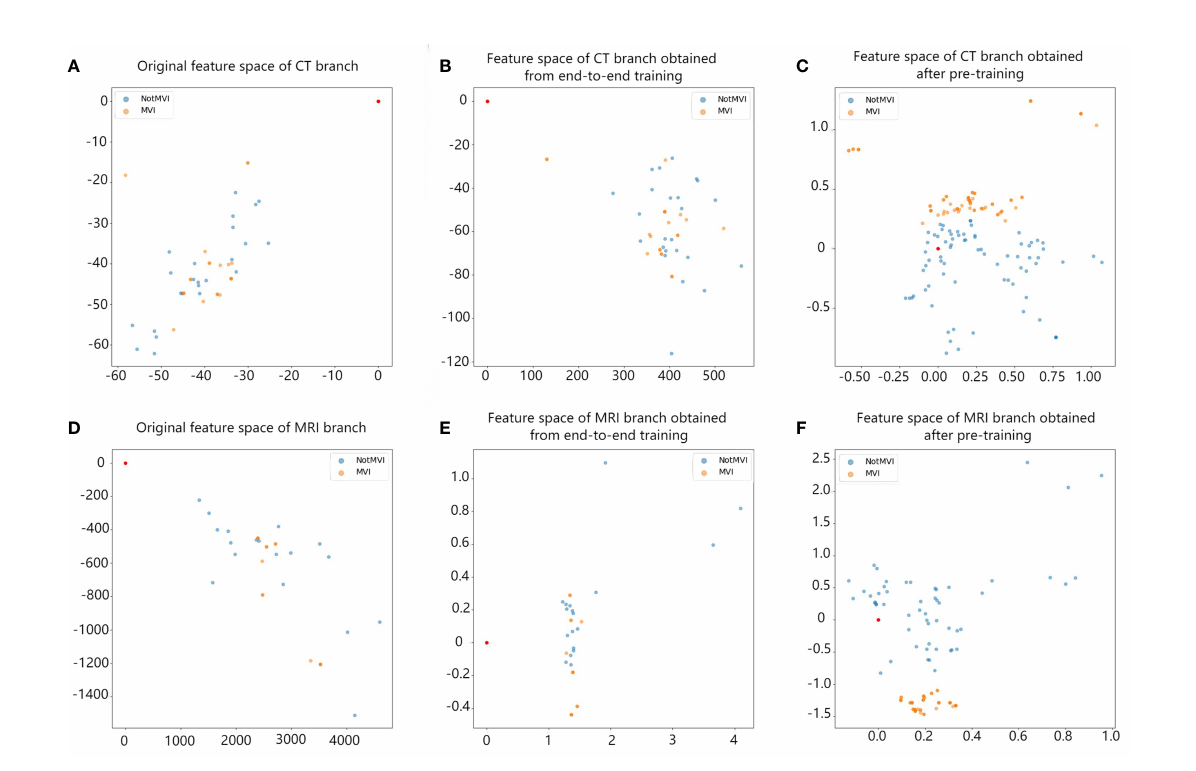
FIGURE 4 The comparison between the feature space obtained by single-branch pretraining based on small sample and the feature space obtained by end-to-end training. Each point in the fi gure represents a lesion. Blue represents MVI-negative lesions, and orange represents MVI-positive lesions. Panels (A, D) represent the original feature space of the CT branch and MRI branch. Blue and orange points are irregularly mixed together. Panels (B, E) show the feature space of the CT branch and MRI branch after end-to-end training. Blue and orange points start to gather, but they are still mixed together. Panels (C, F) show the feature space of the CT branch and MRI branch after single-branch pretraining based on small samples. Points of the same colour begin to gather, and blue points and orange points are basically separated, which improves the ability to distinguish between negative and positive